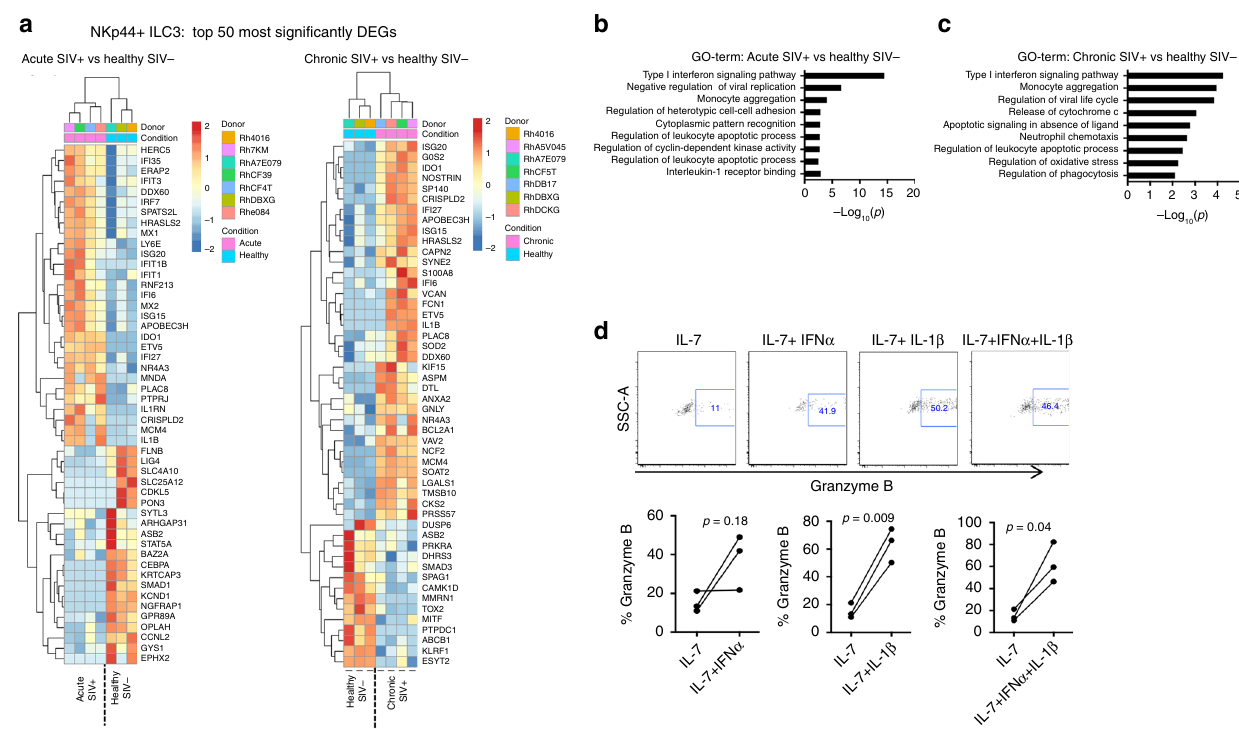
Fig. 8 NKp44 + ILC3s exhibit robust IFN gene signatures in the SIV + MLN. a Gene expression pro fi les of the top 50 most signi fi cantly DEGs among NKp44 + ILC3s in the acute ( N = 3) and chronic SIV + MLN ( N = 4). Color scheme represent standardized gene expression ( z -score) with red and blue signifying up- regulated and down-regulated genes, respectively. The list of top 50 DEGs in a were functionally annotated by GO term analysis for signi fi cantly enriched pathways in acute SIV + ( b ) and chronic SIV + contrasts ( c ). Signi fi cance was determined by a Fisher ’ s exact test on the likelihood of their association compared to other genes in the gene universe. d ILC subpopulations from MLNs of healthy animals ( N = 3) were sorted and stimulated with IL-7 in the presence or absence of IL-1 β and/or IFN α . Intracellular granzyme B was assessed following 6 days of culture. Signi fi cance was determined using the paired Student ’ s t test. ns = P > 0.05, * = P ≤ 0.05, ** = P ≤ 0.01, *** = P ≤ 0.001, and **** = P ≤